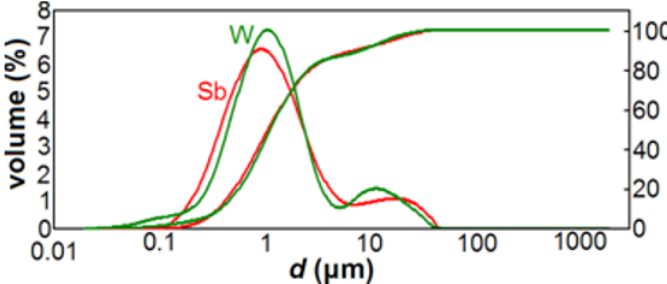
Figure 4. Particle size distribution of pigments Ti Table 3. An effect of composition on particle size and electrokinetic potential of pigments Ti